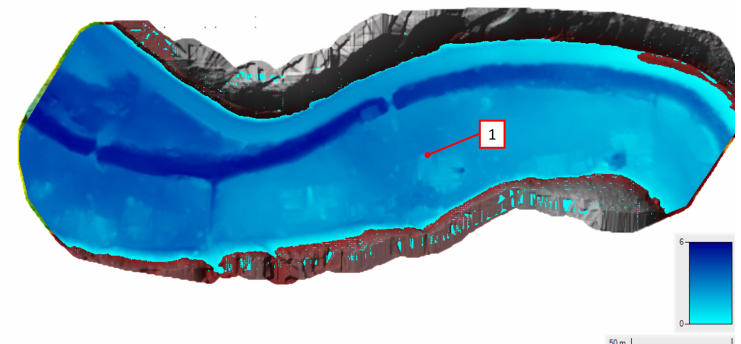
Figure 12. HEC-RAS simulated water depth values using a post-flood environment Digital Elevation Model. The ground-truth measurement location is marked with the label ’1’. This is the same area as the simulation in Figure